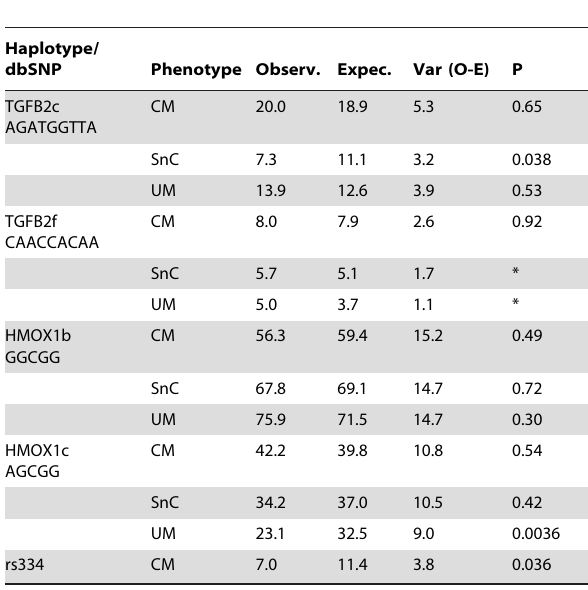
Table 4. Transmission disequilibrium tests for associated TGFB2 and HMOX1 haplotypes and dbSNP rs334.